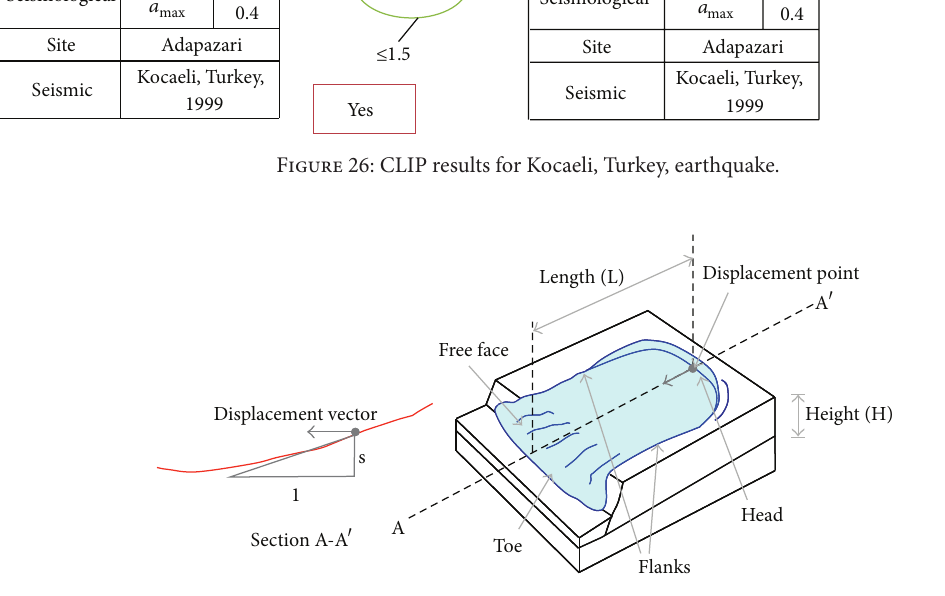
Figure 27: Sketch of lateral spread